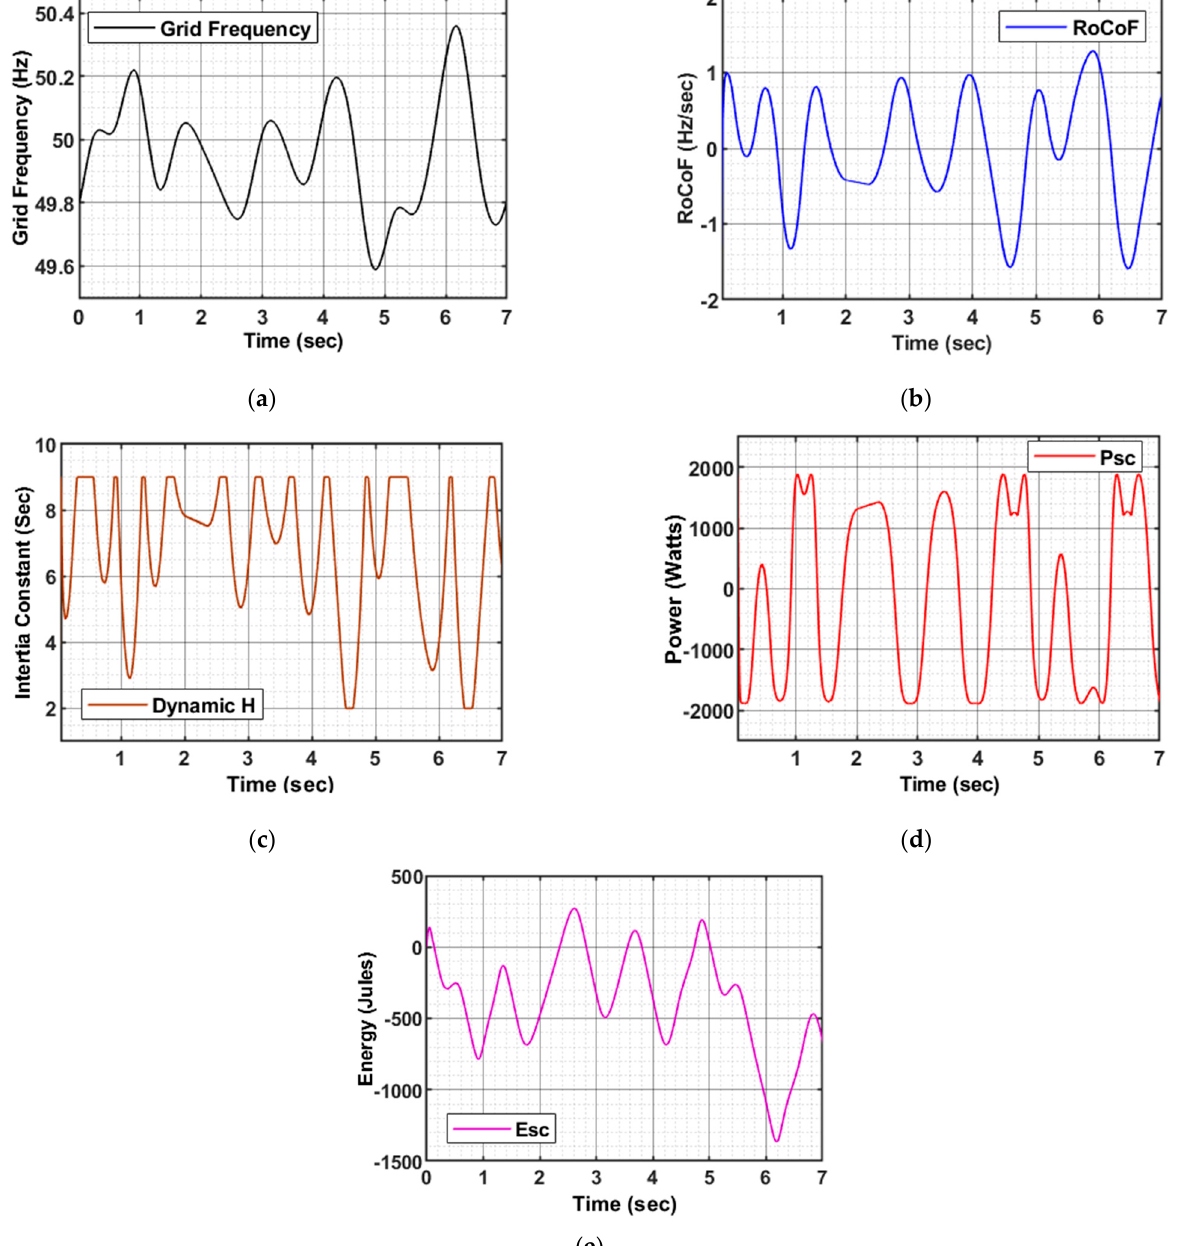
Figure 14. Verification of the proposed DI-based sizing methodology for SIR through MATLAB simulation: ( a ) low-frequency variation in Grid Frequency; ( b ) RoCoF subjected to variation in frequency; ( c ) dynamic inertia as a function of RoCoF; ( d ) estimated SC power; ( e ) estimated SC energy.